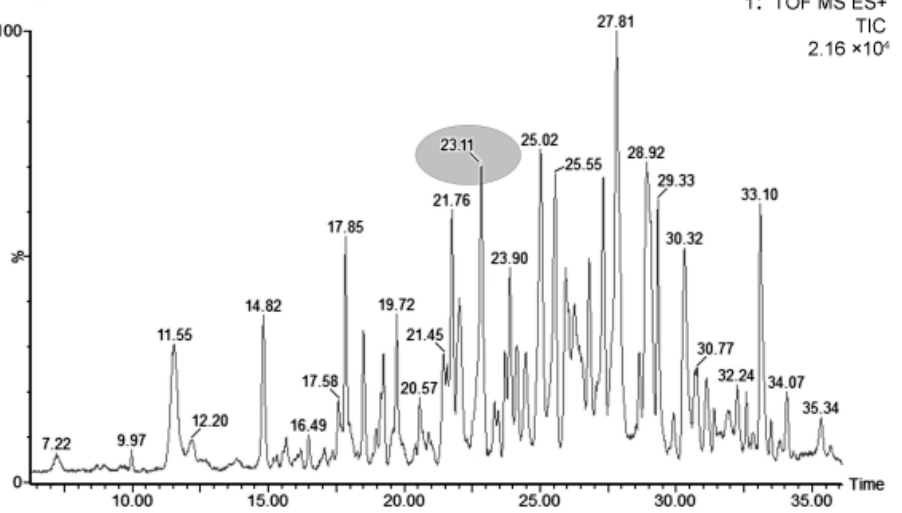
Figure 1. Chromagram of low molecular weight peptides extracted from human milk by SPE.